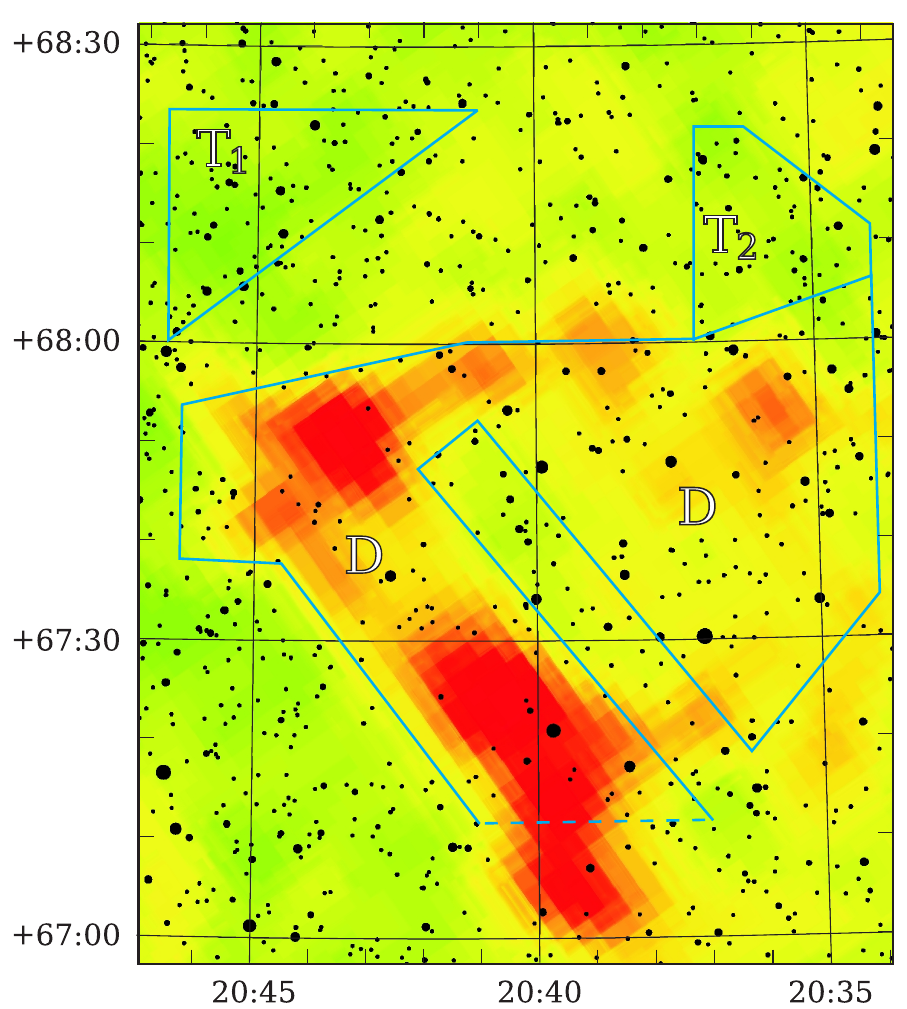
Fig. 1. The investigated area: the extinction map from Dobashi et al. (2005) atlas and the stars down to V = 15 in the background. The stars are plotted by the Chartes du Ciel (Sky Charts) software 1 from the UCAC3 catalog supplemented with Tycho 2. The blue lines limit two most transparent (T 1 and T 2 ) and the dark subareas